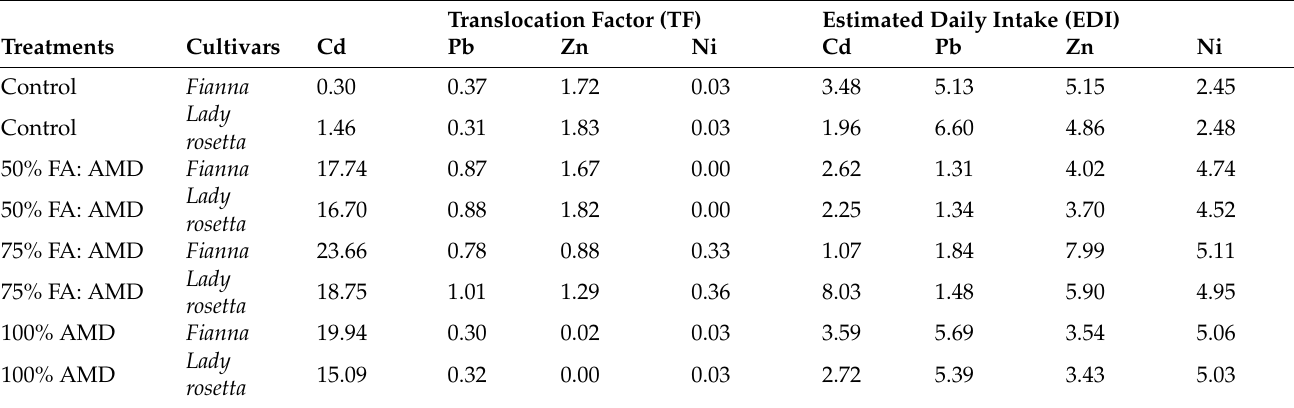
Table 3. Effect of AMD treatments on the Translocation factor (TF) and Estimated Daily Intake (EDI) of two potato varieties ( Fianna and Lady rosetta ). Translocation Factor (TF) Estimated Daily Intake